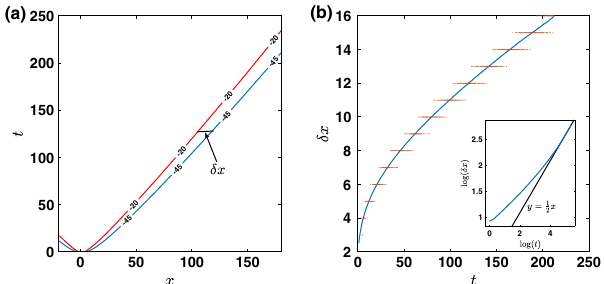
FIG. 4. The diffusive broadening wave front in the mixed-field Ising chain. (a) The contour of log C ð r; t Þ ¼ − 20 and log C ð r; t Þ ¼ − 45 . The system size and the time limit allow the front to travel through about 200 sites. The contours obtained from MPO simulation with bond dimensions 8 and 16 are identical, showing the excellent convergence of our method. (b) The spatial distance δ x between the two contours increases with time, showing definitive broadening of the wave front. In the inset, we plot δ x with t on a log-log plot. The slope of the curve approaches 1 = 2 , strong evidence of diffusive broadening, and the broadening exponent p ¼ 1 .